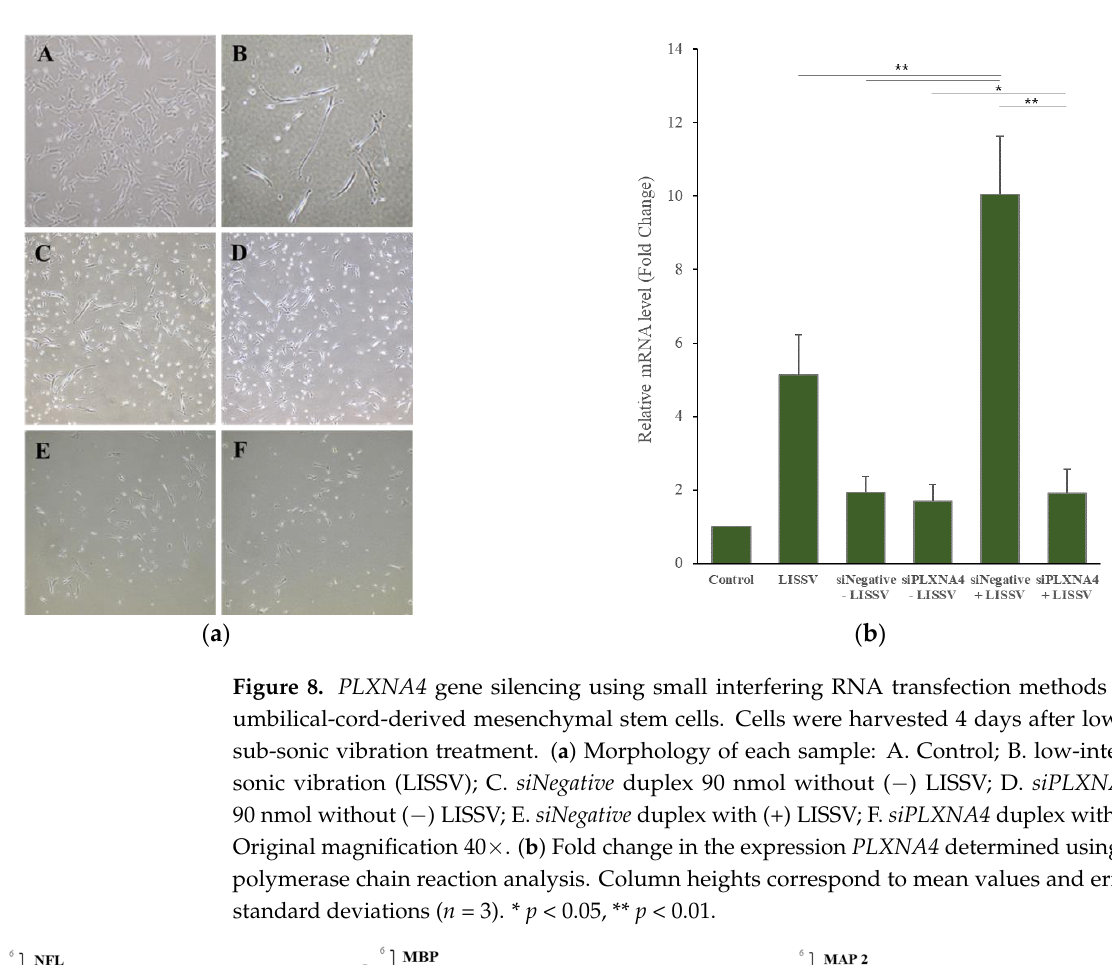
Figure 7. MTT data for siRNA transfection in human umbilical-cord-derived mesenchymal stem cells. Cells were harvested 2 days after siRNA duplex transfection. Column heights correspond to mean values and error bars to standard deviations ( n = 3). * p < 0.05.